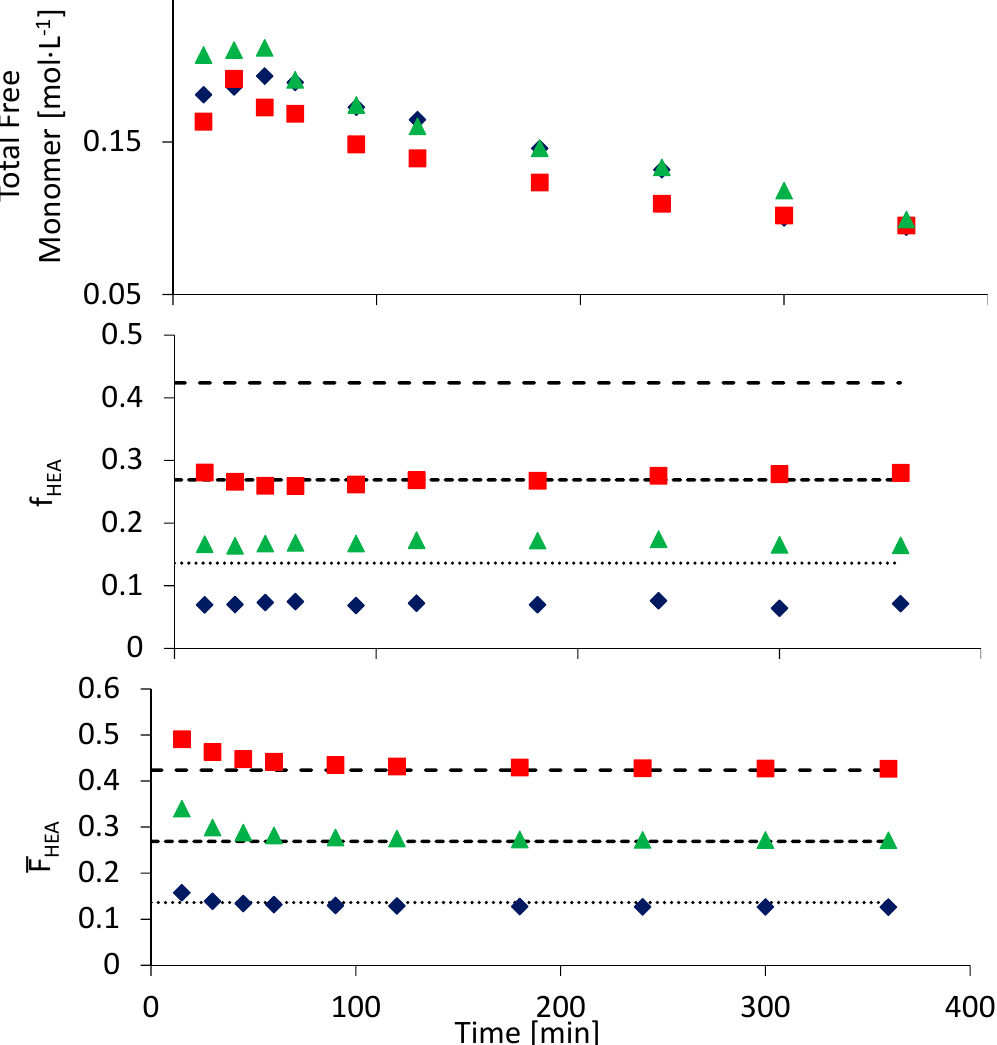
Figure 1. Total free monomer concentration ( top ), HEA molar fraction in the comonomer ( f HEA ) ( middle ) and copolymer ( F HEA ) ( bottom ) for BA/HEA semibatch copolymerizations in esters (BPi) at HEA levels of 12.5 wt % ( ♦ ), 25 wt % ( ▲ ), 40 wt % ( ■ ) in the comonomer feed.